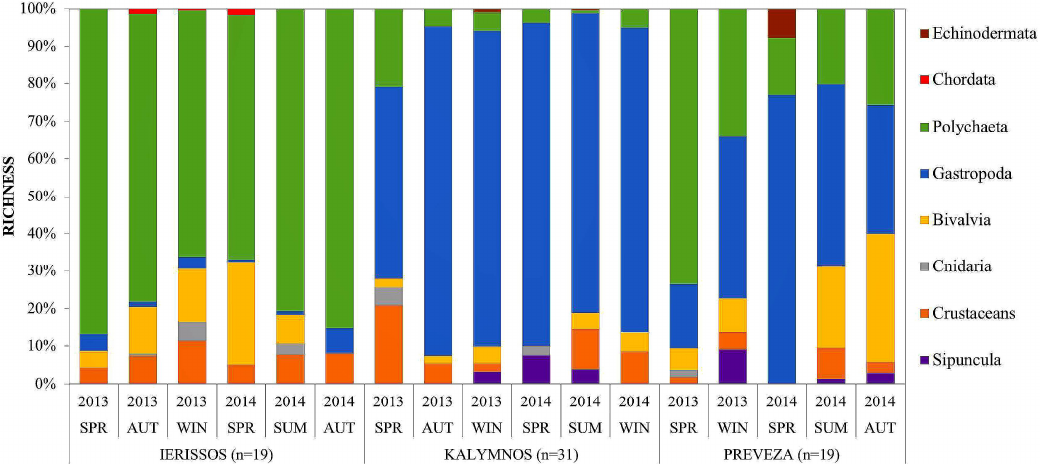
Figure 4. Richness of individuals (%) per season, year, and sampling site. Spring: SPR; Summer: SUM; Autumn: AUT; Winter: WIN; n: Total number of samples.